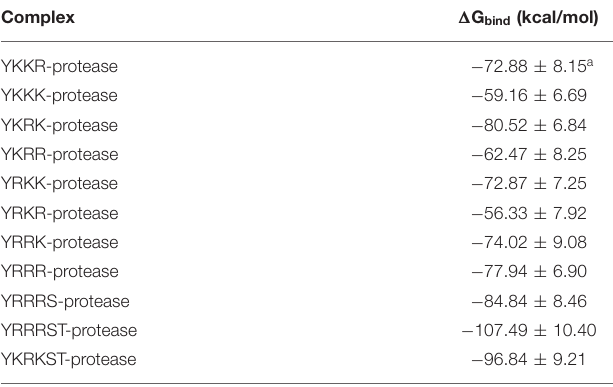
TABLE 1 | The relative binding free energies ( 1 G bind ) of different